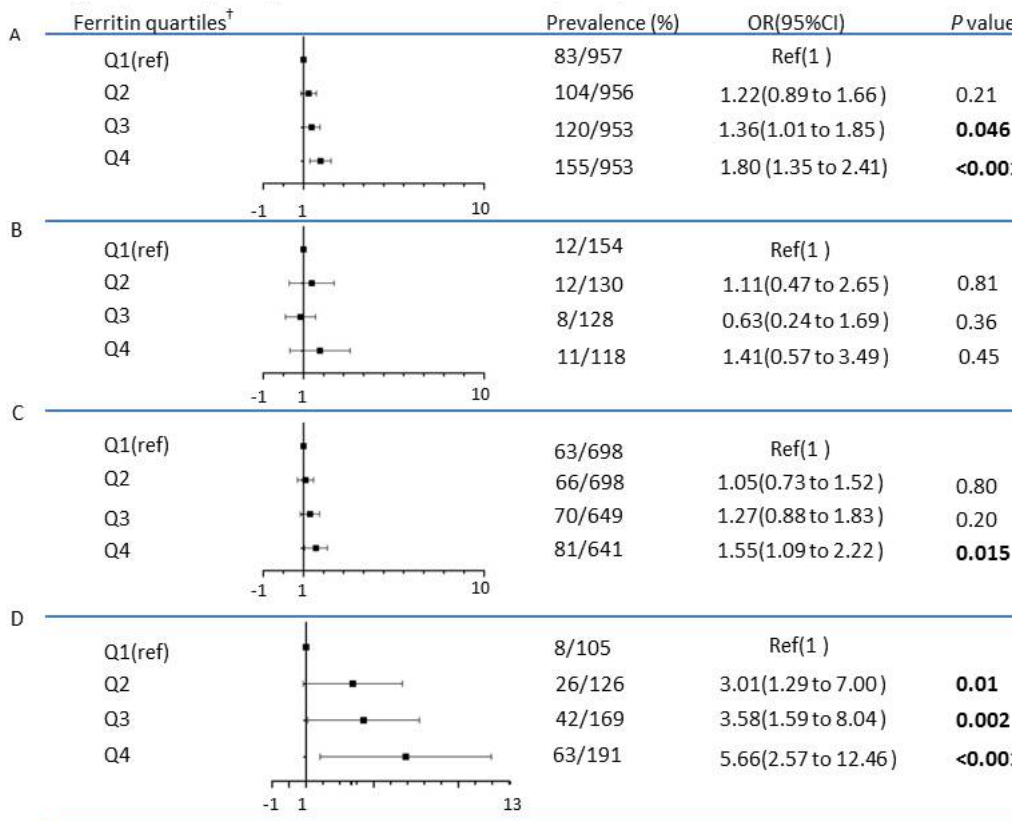
Figure 1. Adjusted odds ratio (OR) for dyslipidemia associated with sex-specific quartiles of ferritin among the overall participants and PBF-stratificated participants. ( A ) The overall participants ( n = 3819) ( B ). Participants with low fat (PBF Z-scores < − 1) ( n = 530) ( C ). Participants with healthy fat ( − 1 ≤ PBF Z-scores ≤ 1 ( n = 2686) ( D ). Participants with overweight and obese (PBF Z-scores > 1) ( n = 591). * ORs (95% CIs) were adjusted for age, gender, WHtR, pubertal stage (pre-pubertal, pubertal), sedentary time, and energy intake. † Sex-specific quartiles of ferritin were defined among the overall participants and among participants with low fat, healthy fat, and overweight/obesity, separately. ORs shown in bold font are statistically significant at p < 0.05.